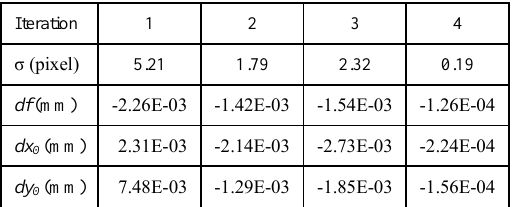
Table 5. The corrections of interior orientation parameters of Trail